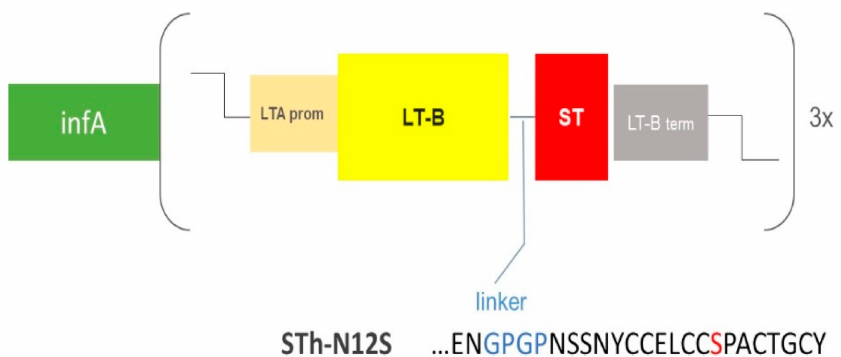
Figure 1. Schematic illustration of the genetic construct carried by the invasion plasmid of ShigETEC. LTB is fused to ST via a GPGP (GlyPro) linker (blue). ST is detoxified by an N12S mutation (red). Expression is driven by the LTA promoter and halted by the LTB termination sequence. The fusion gene is expressed as a 3 × tandem repeat. The construct also expresses infA as a separate gene with intrinsic promoter and terminator